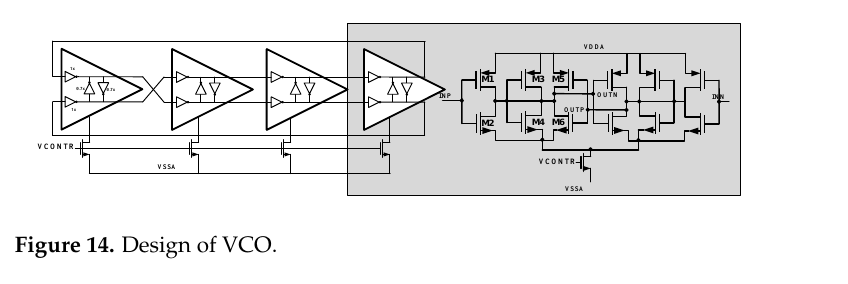
Figure 13. VCO control circuit.